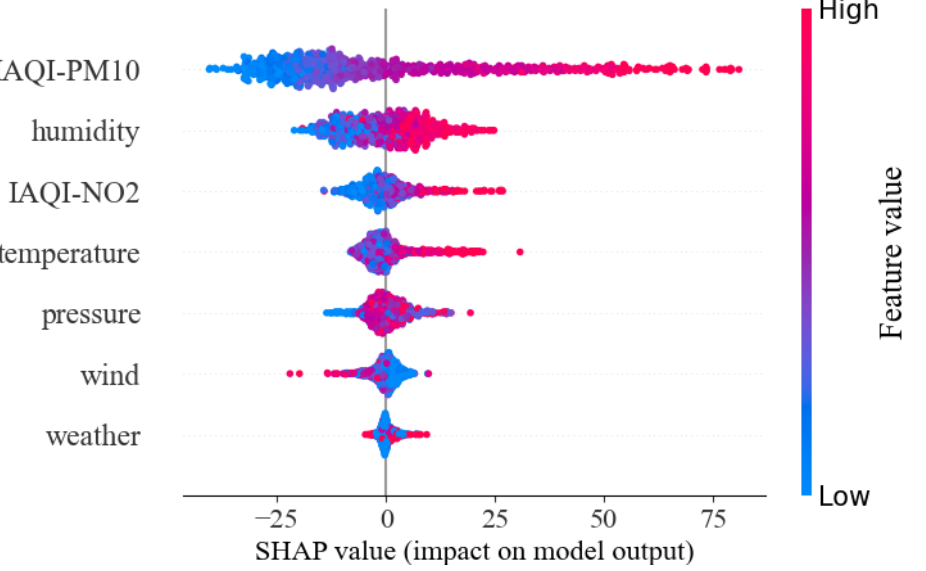
Figure 15. Influence of input features on IAQI-PM 2.5 prediction (from global perspective).